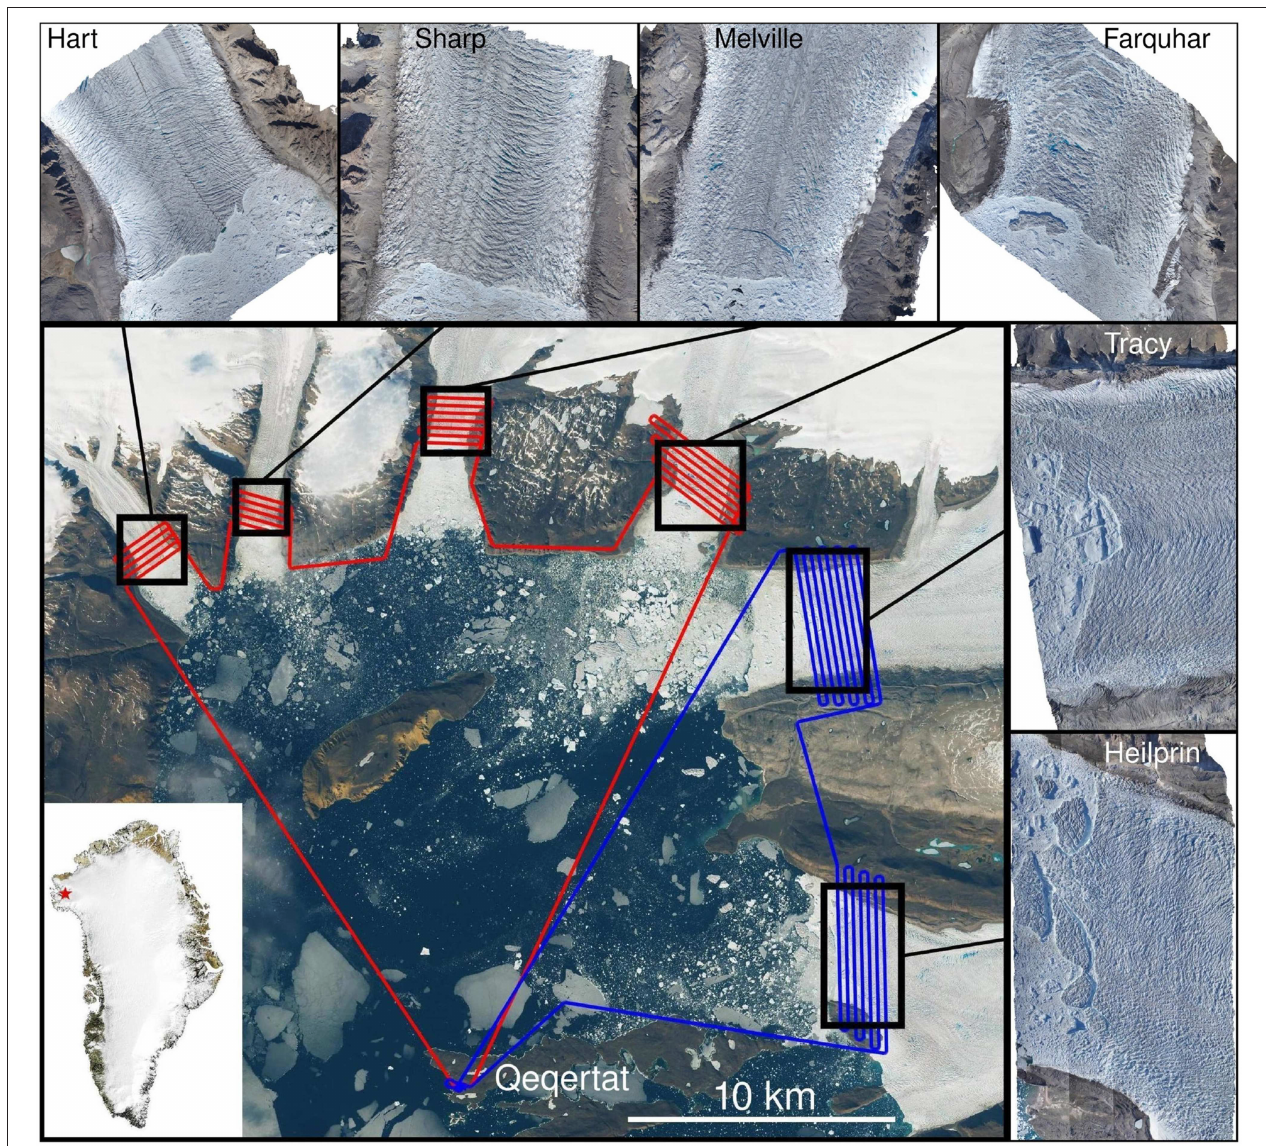
FIGURE 1 | Sentinel-2A satellite image of the northeast most part of the Inglefield Bredning showing the settlement of Qeqertat and the six calving glaciers (Hart, Sharp, Melville, Farquhar, Tracy, and Heilprin) that we surveyed on 17 July 2017. The blue and red lines indicate the trajectory of the two daily UAV missions covering all glaciers. A map of Greenland (Source: MODIS) is displayed in the lower left and the location of the Inglefield Bredning is indicated by a red star.